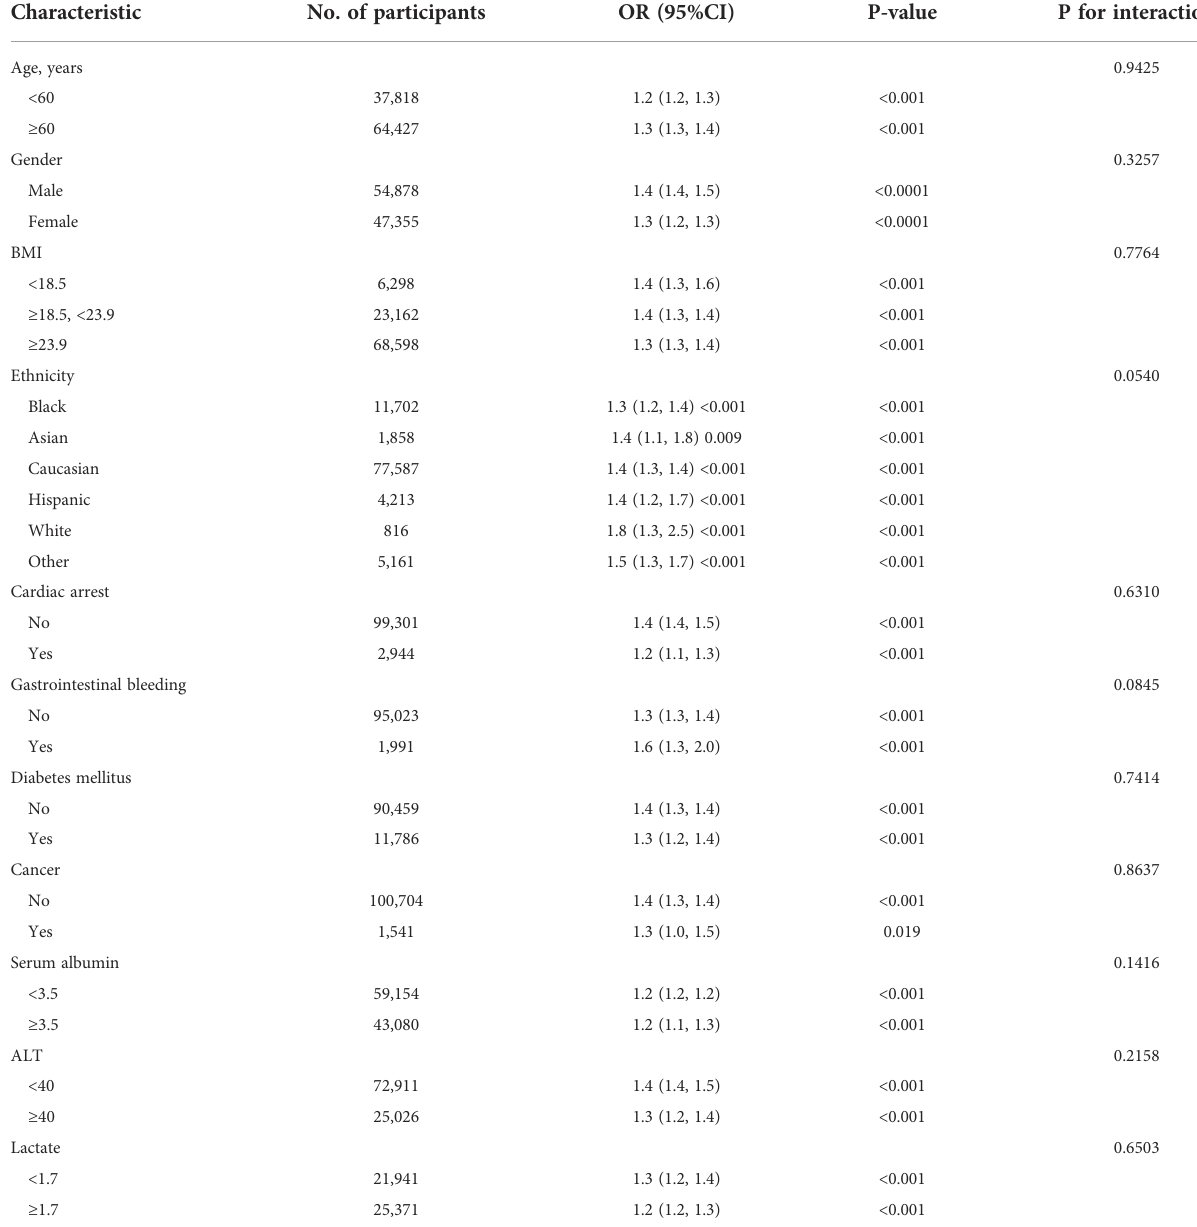
TABLE 4 Effect size of albumin-corrected calcium (mg/dl) and 30-day in-hospital mortality in prespeci fi ed and exploratory subgroups. Characteristic No. of participants OR (95%CI) P-value P for